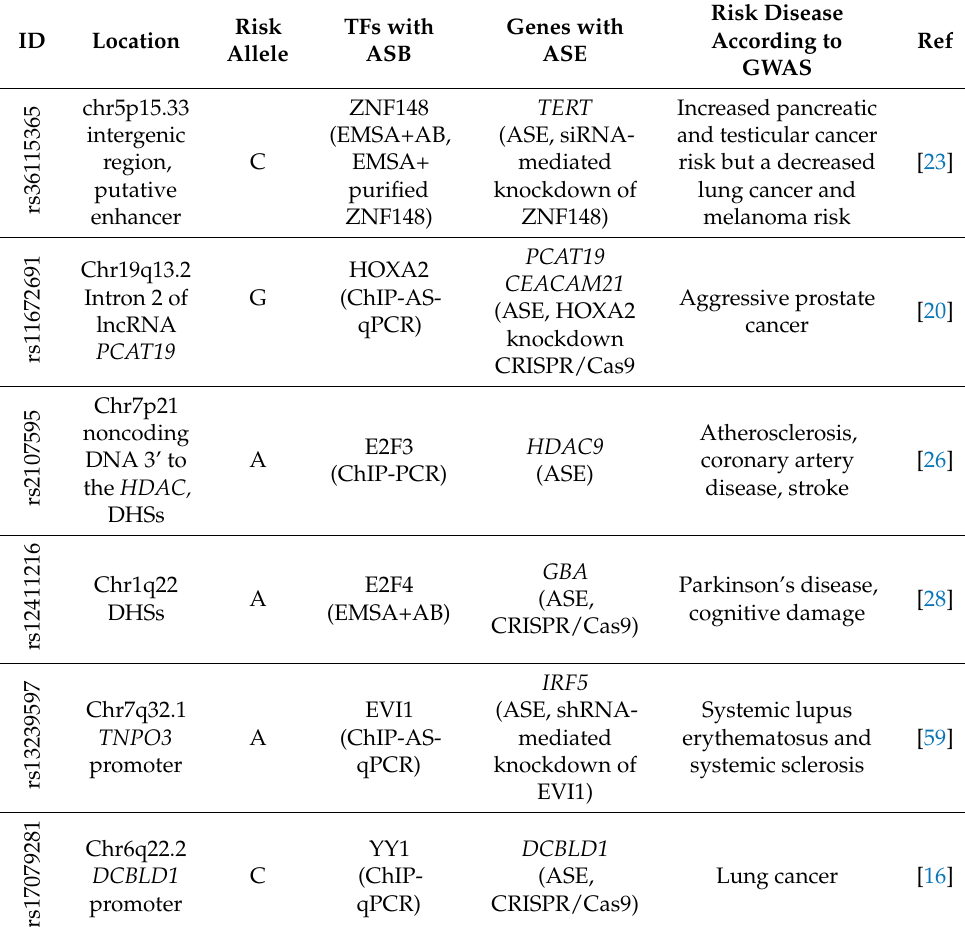
Table 2. Examples of rSNPs altering TFBSs and affecting gene